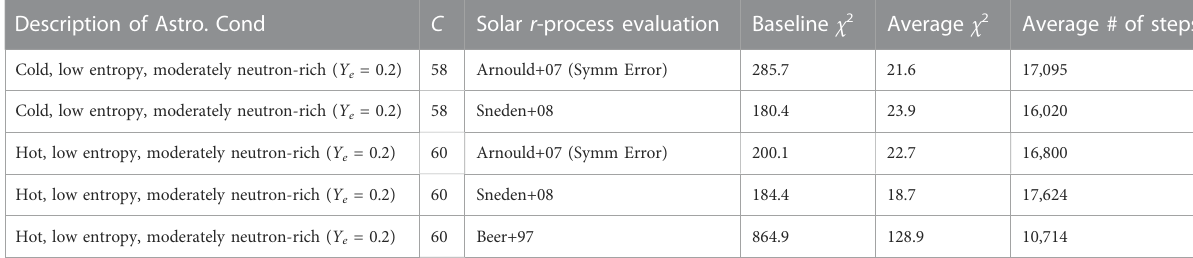
TABLE 1 Summary of the χ 2 for the DZ baseline and MCMC results for all cases presented in this work. Description of Astro.